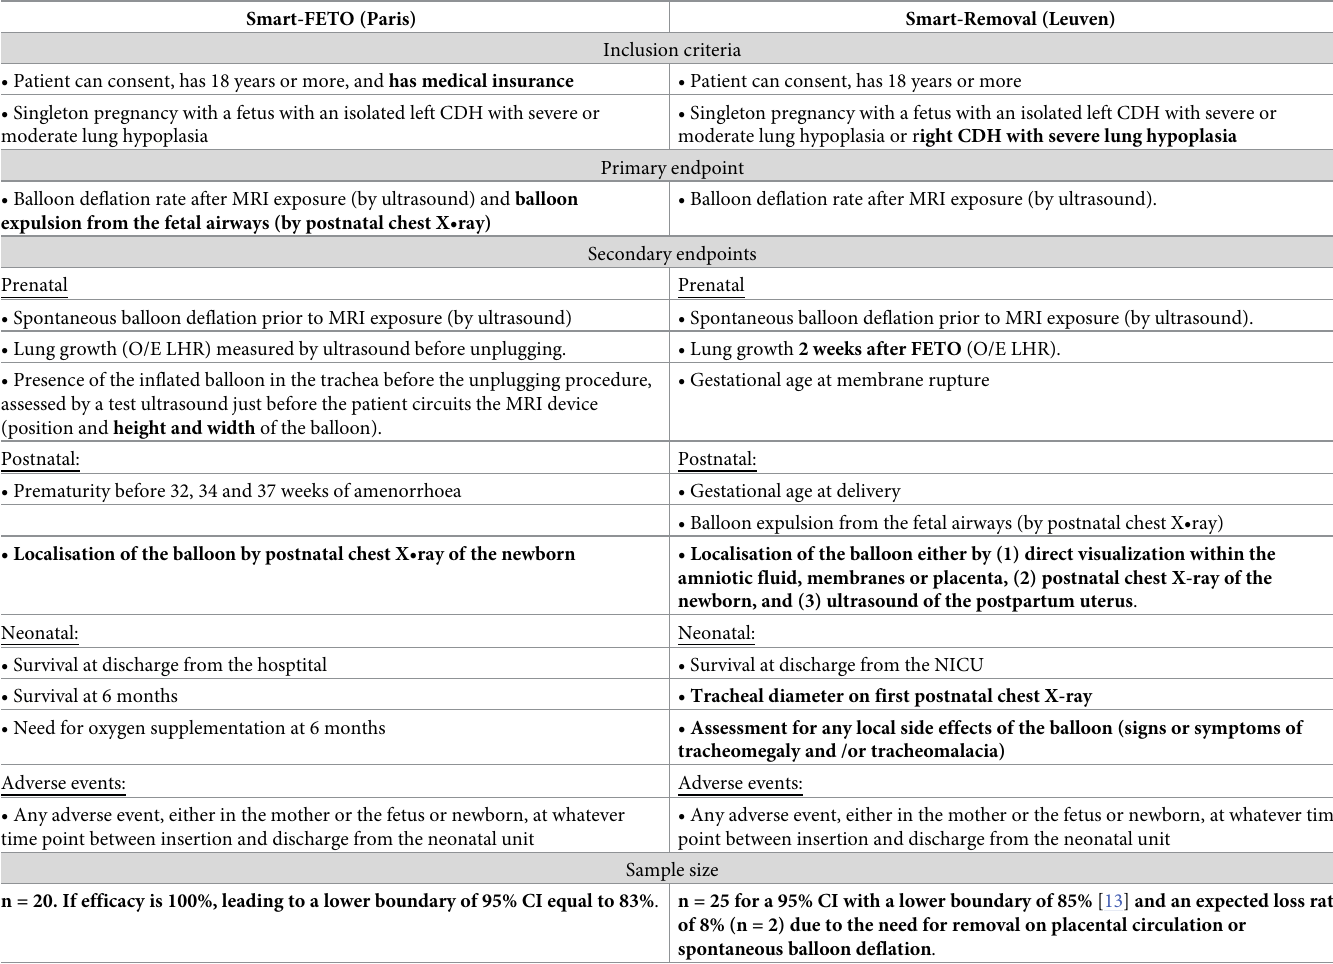
Table 2. Inclusion criteria and outcome measurements in both studies. Differences are displayed in